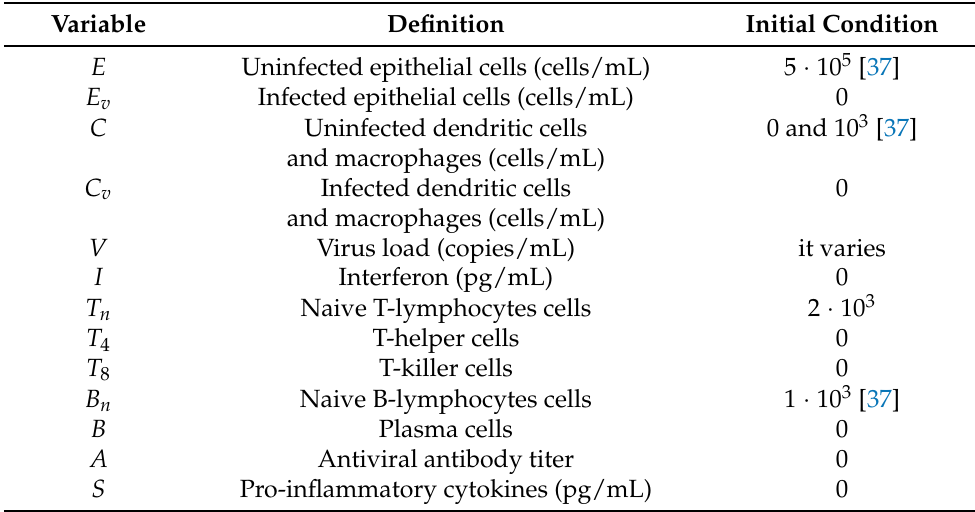
Table A4. Variables, definitions and initial